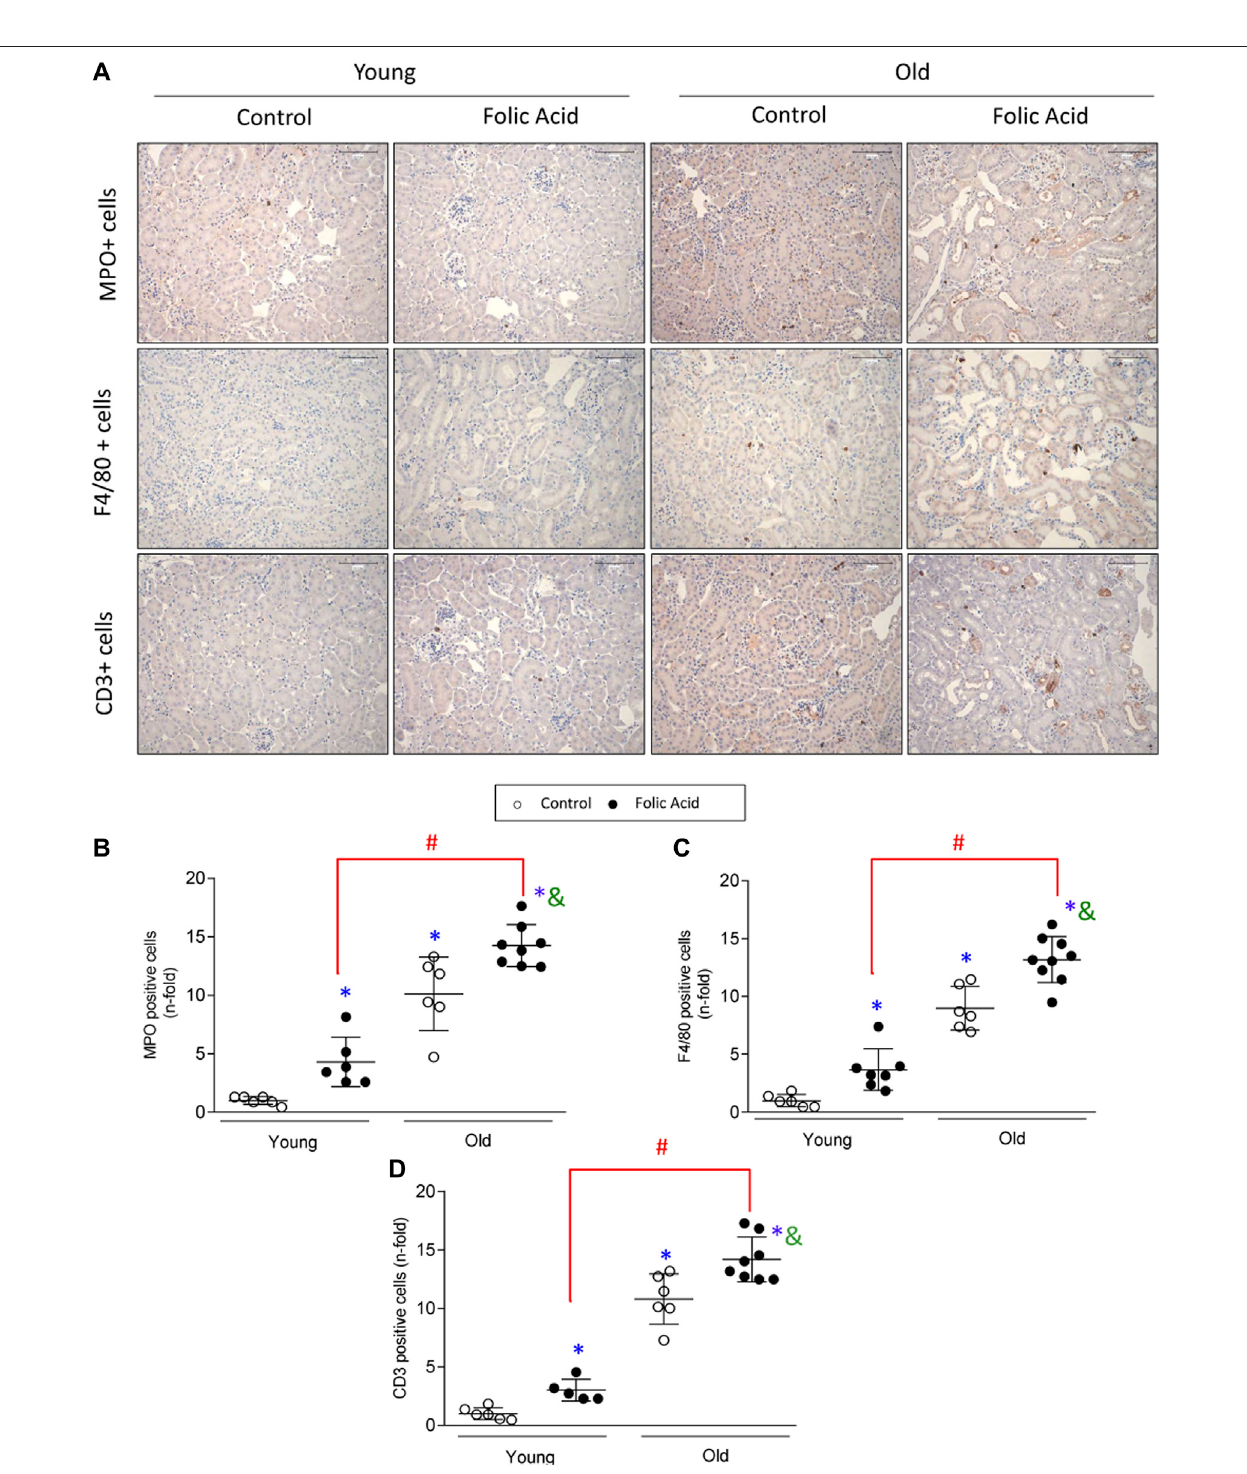
FIGURE 3 | Characterization of in fl ammatory in fi ltrate in the acute phase of folic acid (FA) nephropathy in young and old mice. Folic Acid (FA; 125 mg/kg) was injected in 3-months-old (Young) and 1-year-old (Old) C57BL/6 mice and kidneys were studied after 48 h. In fl ammatory cell in fi ltration was evaluated using antibodies against myeloperoxidase (neutrophils), F4/80 (monocytes/macrophages/dendritic cells) and CD3 (T lymphocytes). (A) Representative micrographs from each group. Scale bars (cid:2) 100 μ m. (B – D) Quanti fi cation of MPO (B) , F4/80 (C) , and CD3 (D) positive cells. Data are shown as n-fold and expressed as mean ± SD of n (cid:2) 6 – 9 animalspergroup.* p < 0.05vs.controlyoungmice, # p < 0.05vs.FA-injectedyoungmice, & p < 0.05vs.controloldmice.Theparametricone-wayANOVAstatisticaltest was